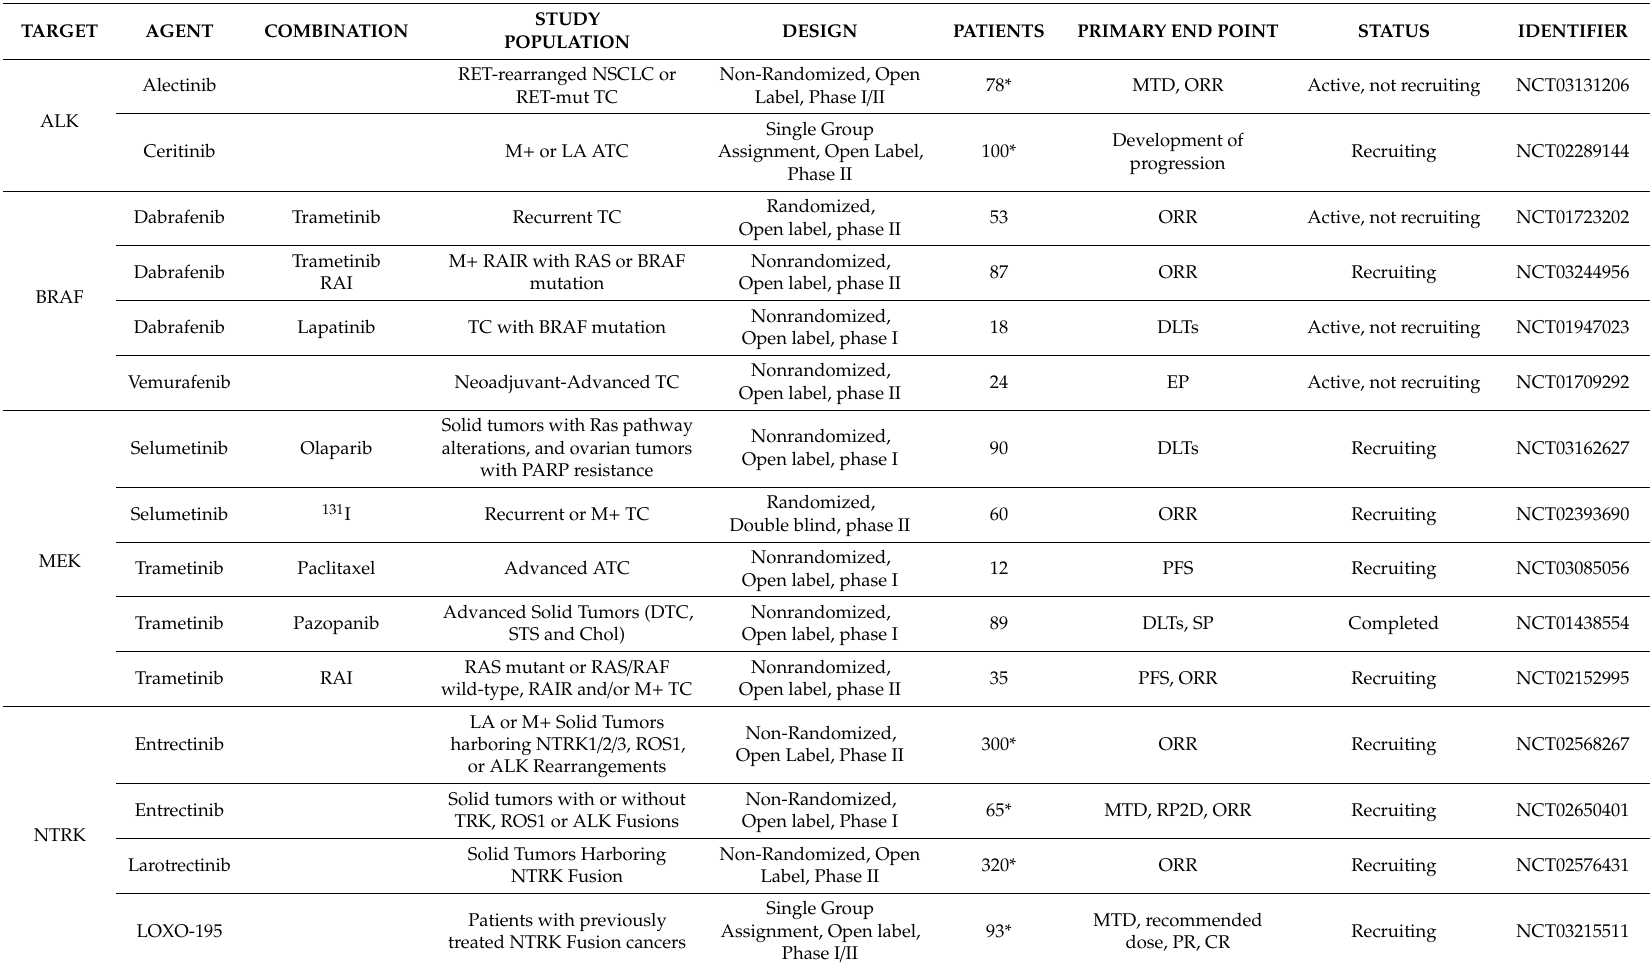
Table 2. Clinical trials with single target